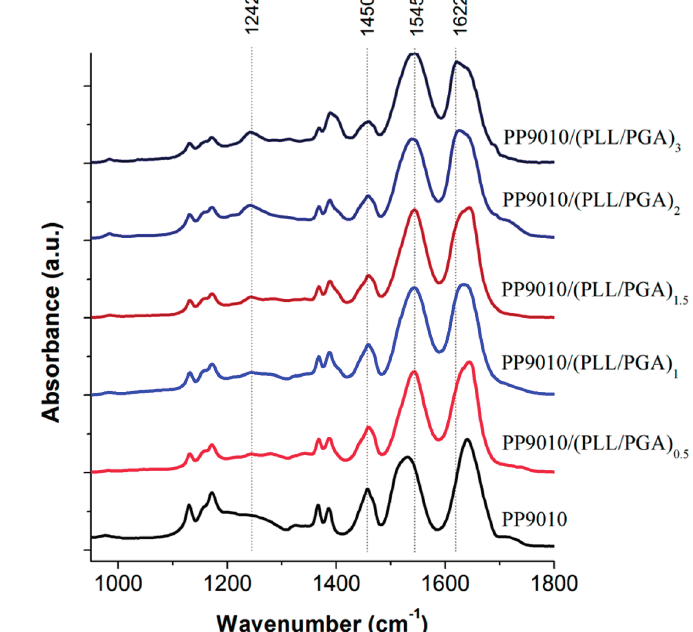
Figure 4. Attenuated total reflectance FT-IR spectroscopy (ATR-FTIR) spectra of polypeptide-coated P(NIPAM- co -MAA) MGs. Reproduced with permission from [27], copyright 2012, American Chemical